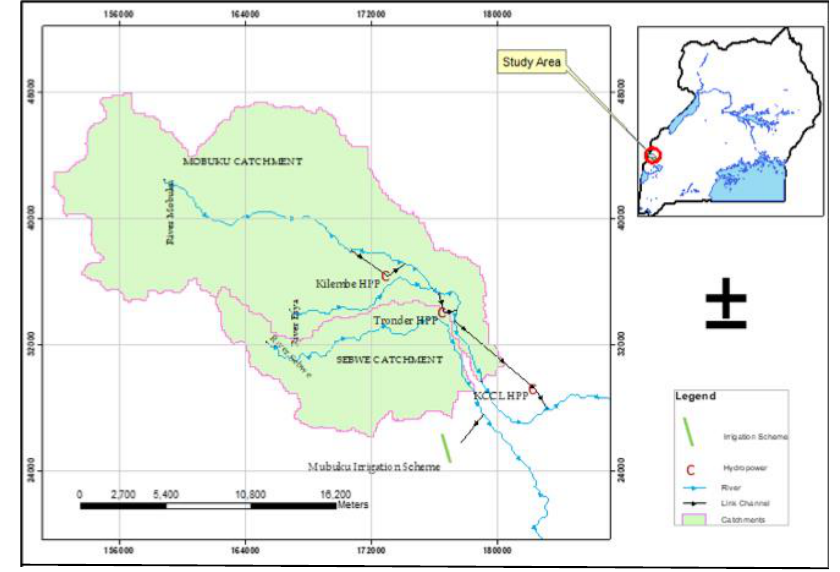
Figure 1 . Mubuku irrigation scheme in Sebwe-catchment (source: Food and Agriculture Organization, “Strengthening agricultural water efficiency and productivity on the African global level” project documents).